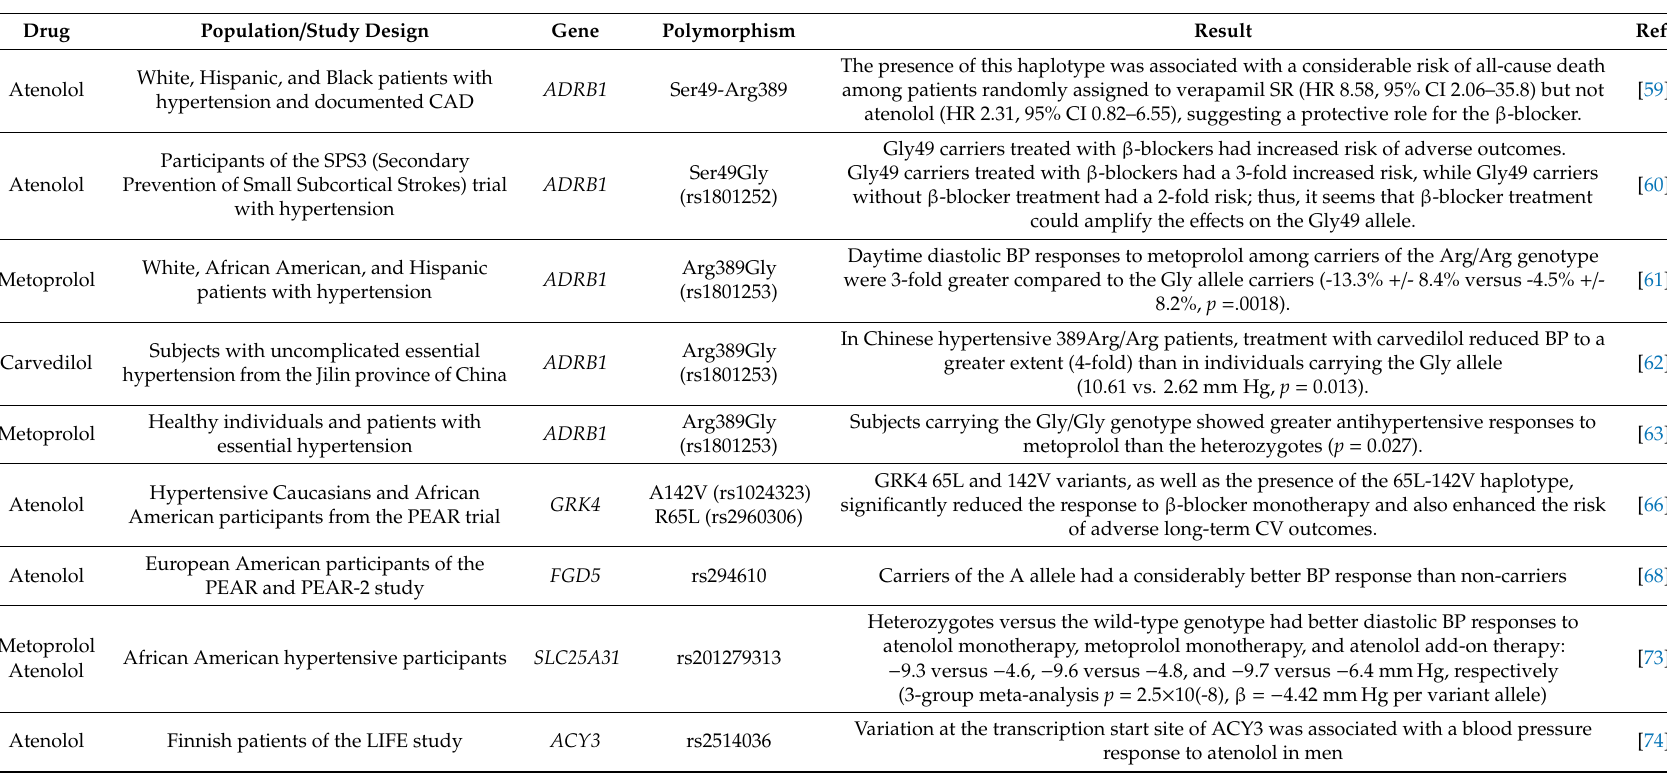
Table 3. A summary of the results of most interesting studies on the β -adrenergic antagonists presented in this